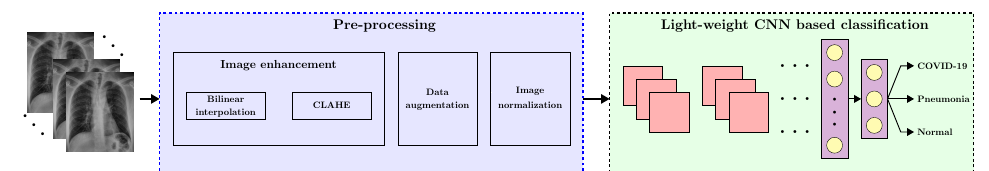
Figure 2. Block diagram of the proposed approach for automated detection of COVID-19 infection.